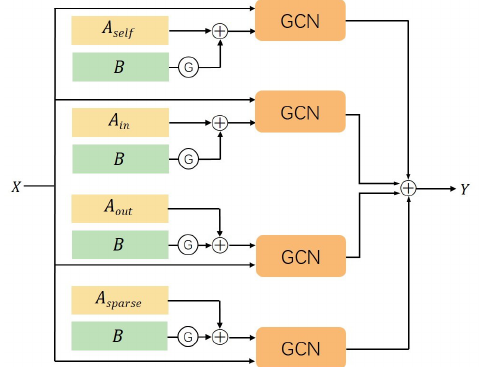
Figure 6. The spatial GCN in a basic block.